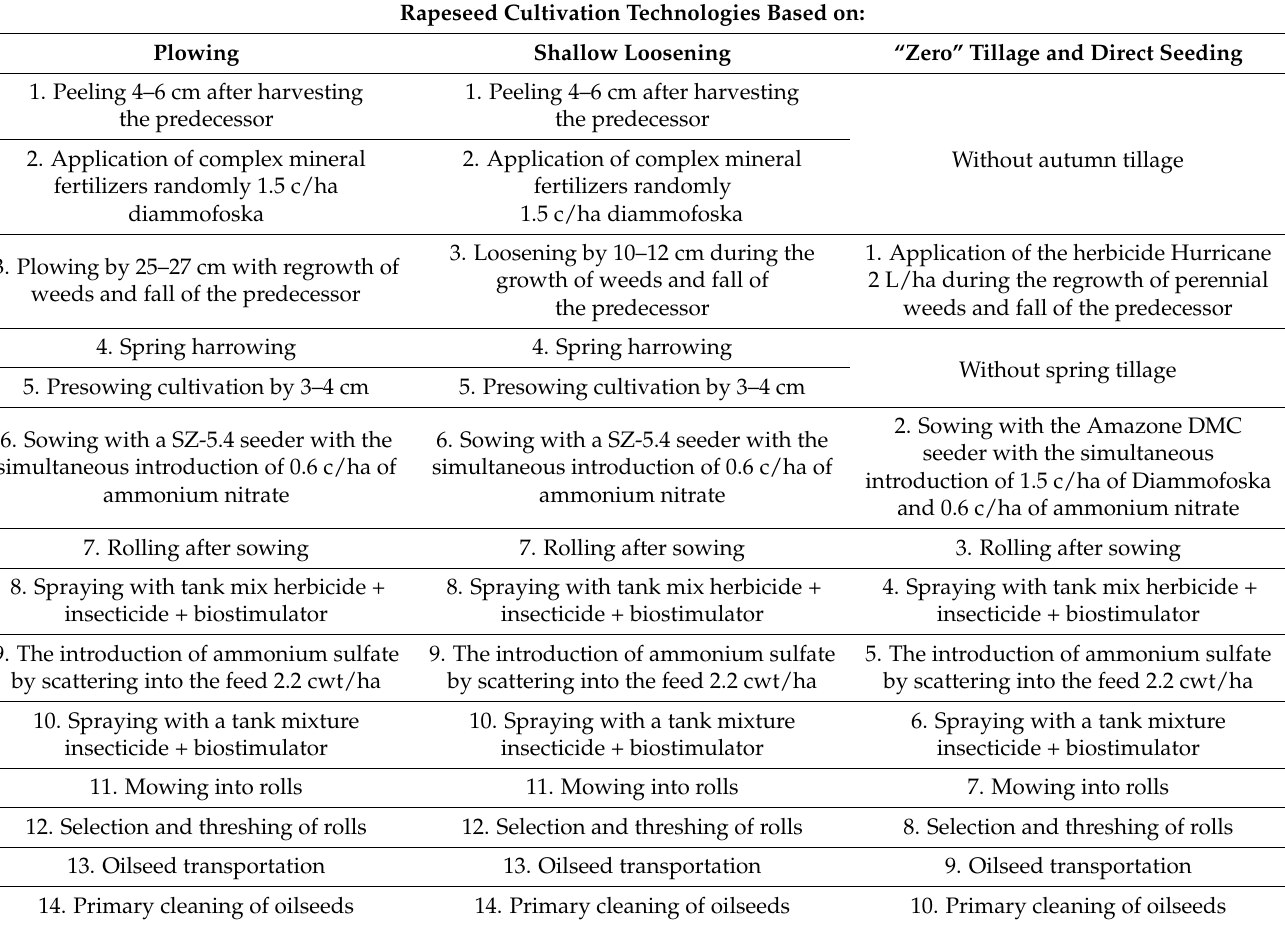
Table 9. List of technological operations in the studied technologies of cultivation of spring